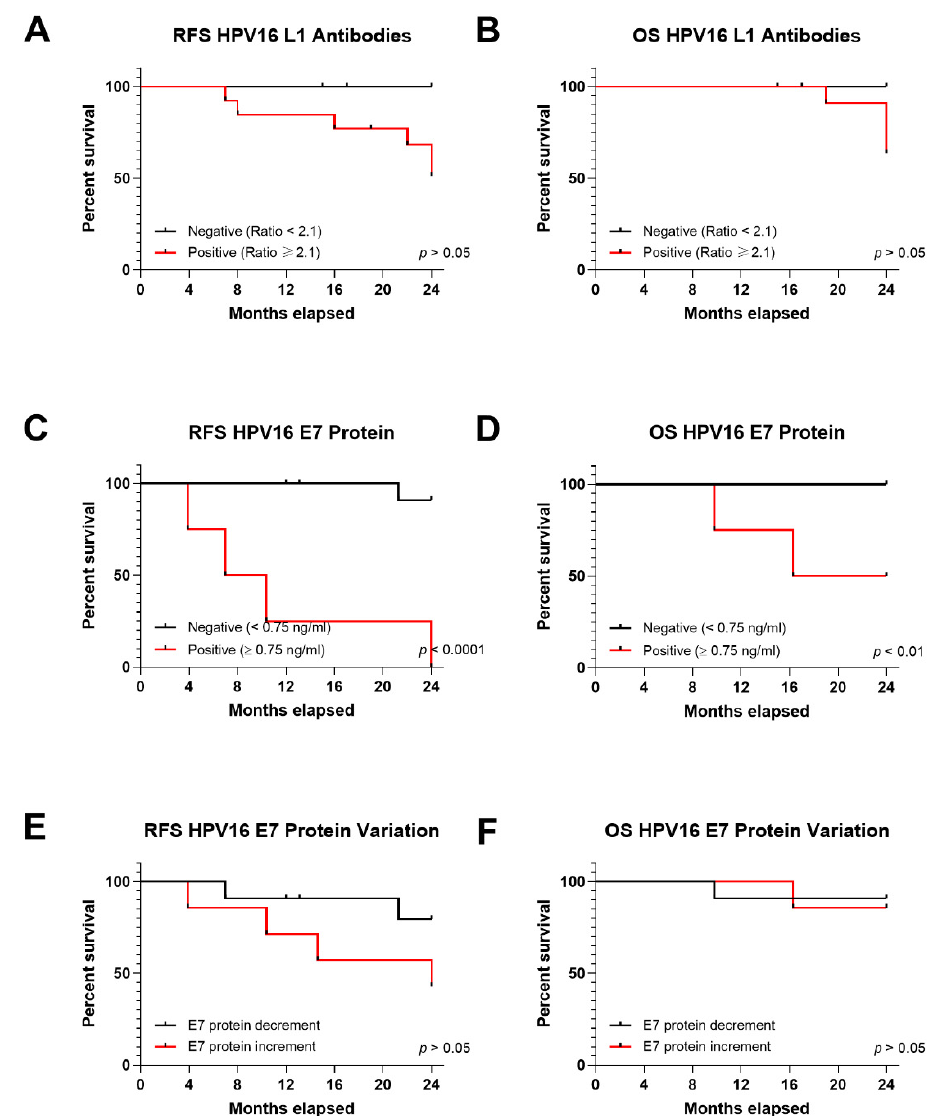
Figure 4. Kaplan-Meier (KM) curves for serological tests representing RFS and OS in HNSCC patients for HPV16 L1 and OPSCC for E7 oncoprotein; KM of ( A ) RFS and ( B ) OS for HPV16 L1 in HNSCC patients; KM of ( C ) RFS and ( D ) OS for HPV E7 oncoprotein in serum from HPV-positive OPSCC patients; KM of ( E ) RFS and ( F ) OS for increment or decrement of E7 oncoprotein in serum from OPSCC patients during follow-up. Statistical significance was indicated as p < 0.05.